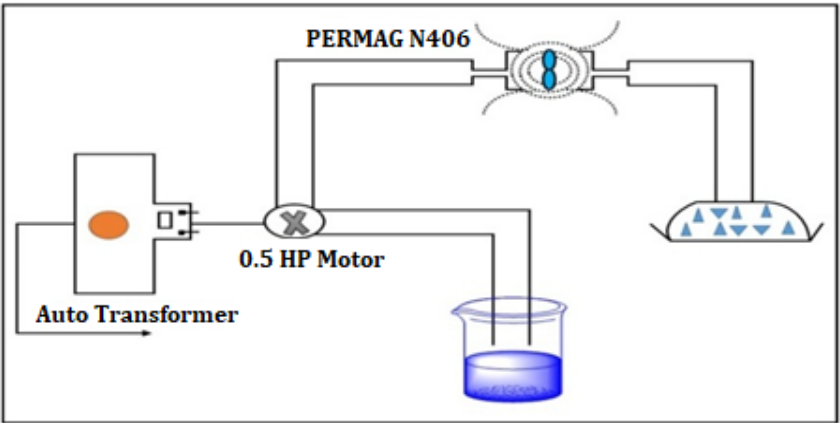
Figure 1. Schematic diagram of MW